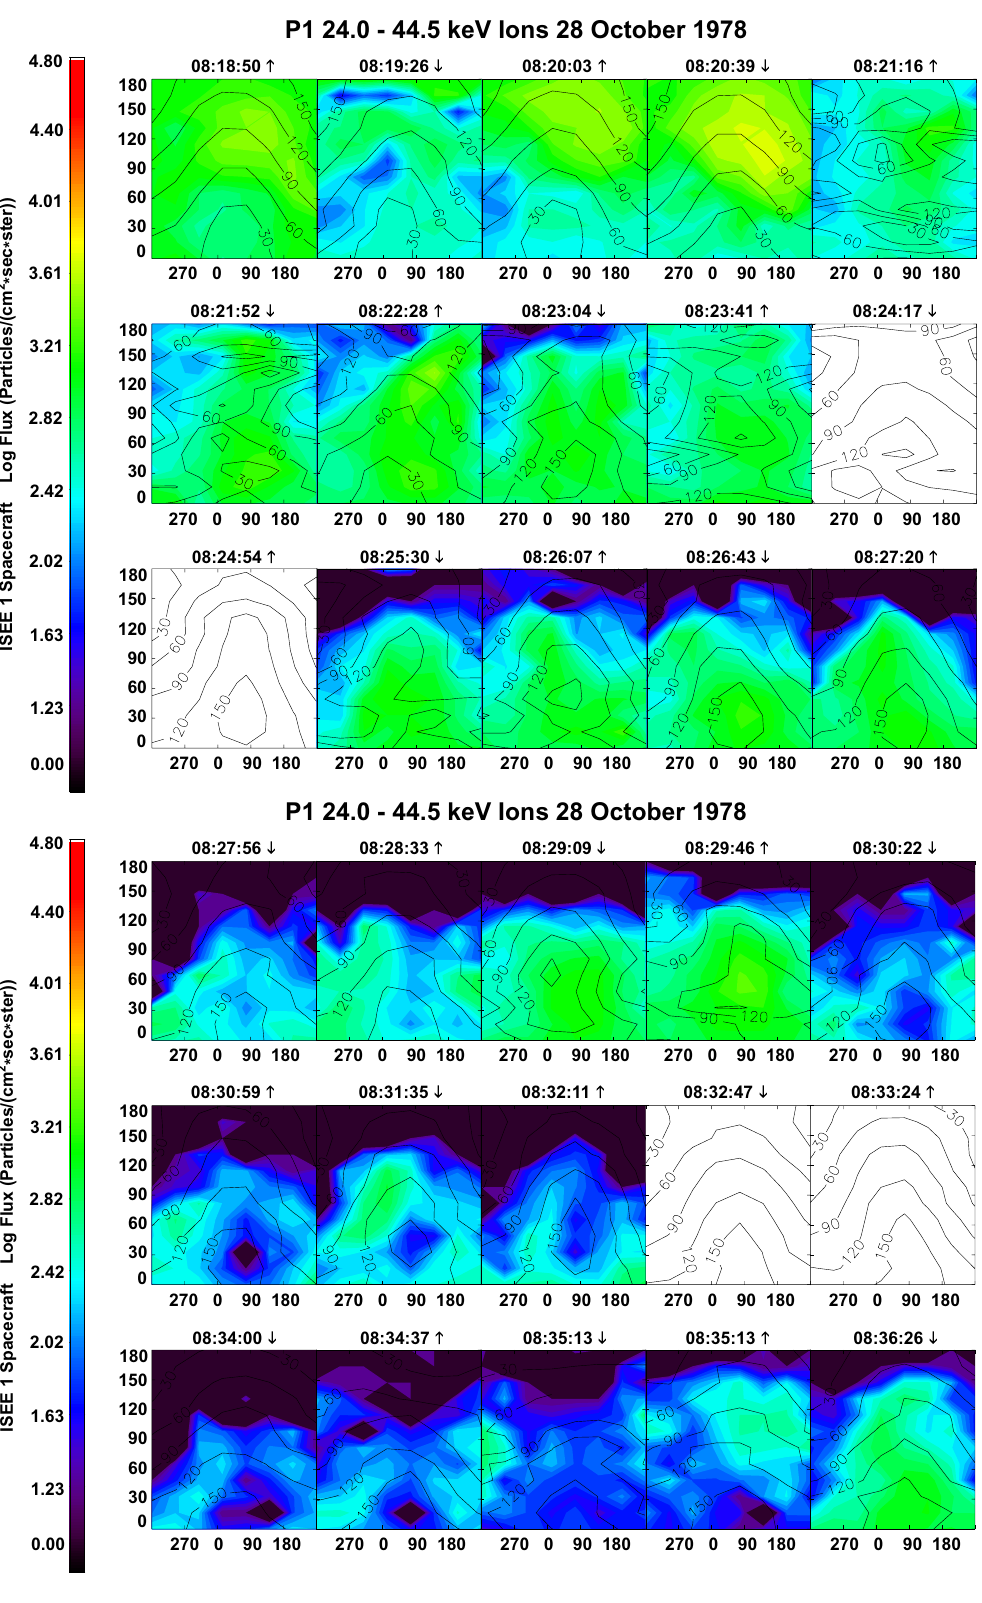
Fig. 7. A time sequence of southern hemispheric PADs for 24 to 44keV ions on 28 October 1978 (Day301) beginning from (a) 08:18:50UT to (b) ending at 08:36:26UT for the ISEE-1 Medium Energy Particles Experiment P1